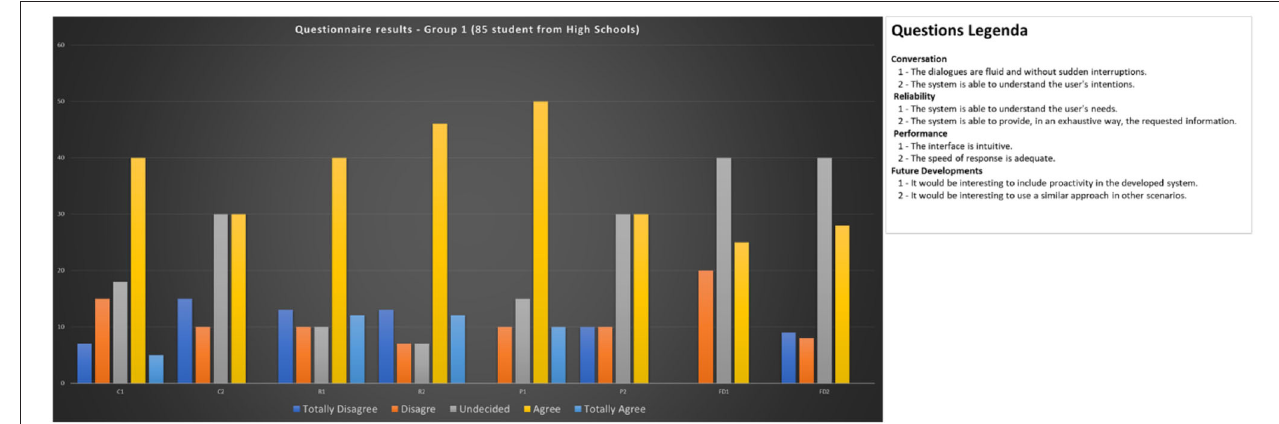
FIGURE 10 | Questionnaire results for Group 1 (students).